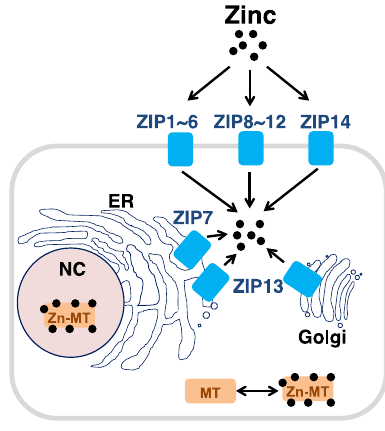
Figure 1. Zinc transporters and metallothionein (MT) are involved in intracellular zinc homeostasis. NC; nucleus, ER; endoplasmic reticulum, Zn; zinc.